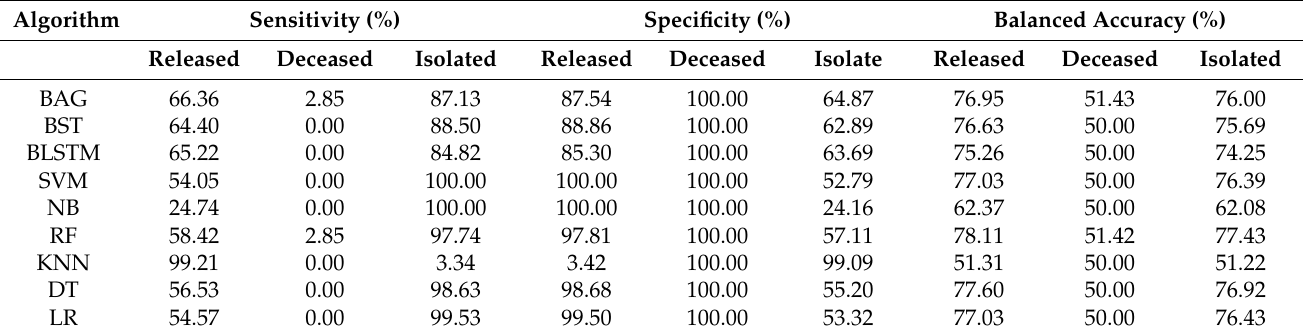
Table 6. Performance of BBNR on BAG, BST, BLSTM, SVM, NB, RF, KNN, DT, and